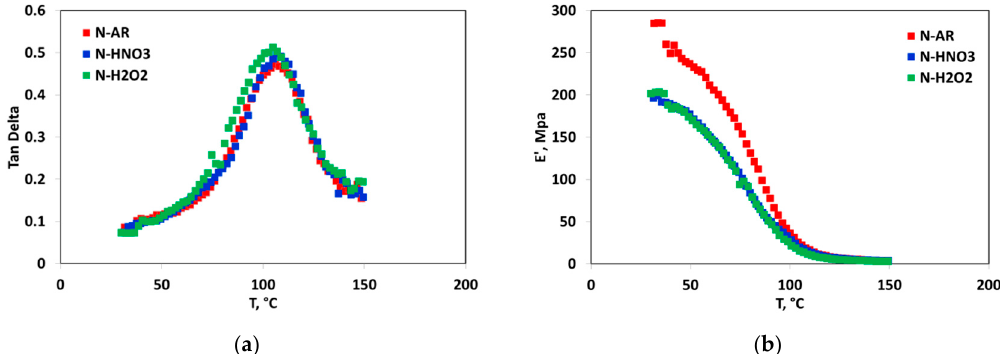
Figure 6. ( a ) tan δ and Storage modulus trend as a function of the temperature of N-AR (red squares), N-HNO3 (blue squares) and N-H2O2 (green squares) membranes.